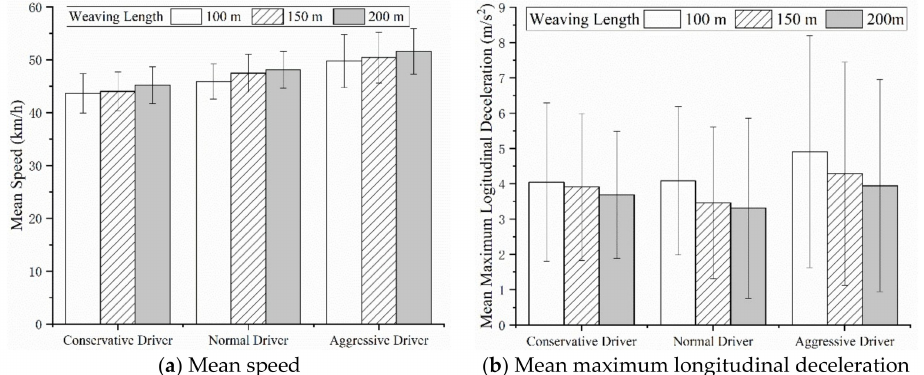
Figure 10. Mean speed and mean maximum longitudinal deceleration for different weaving